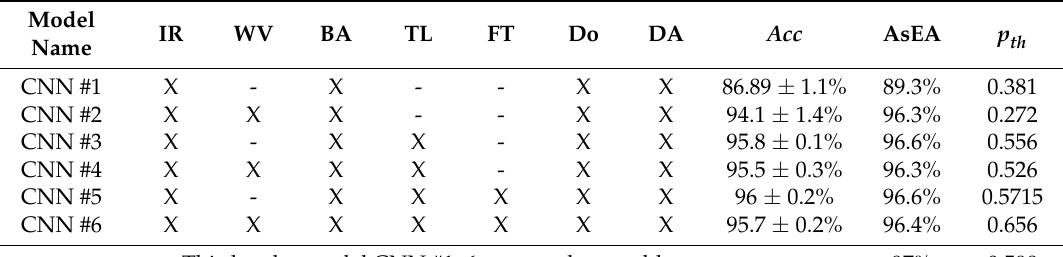
Table 2. Accuracy score of each model with the best hyper-parameters combination.